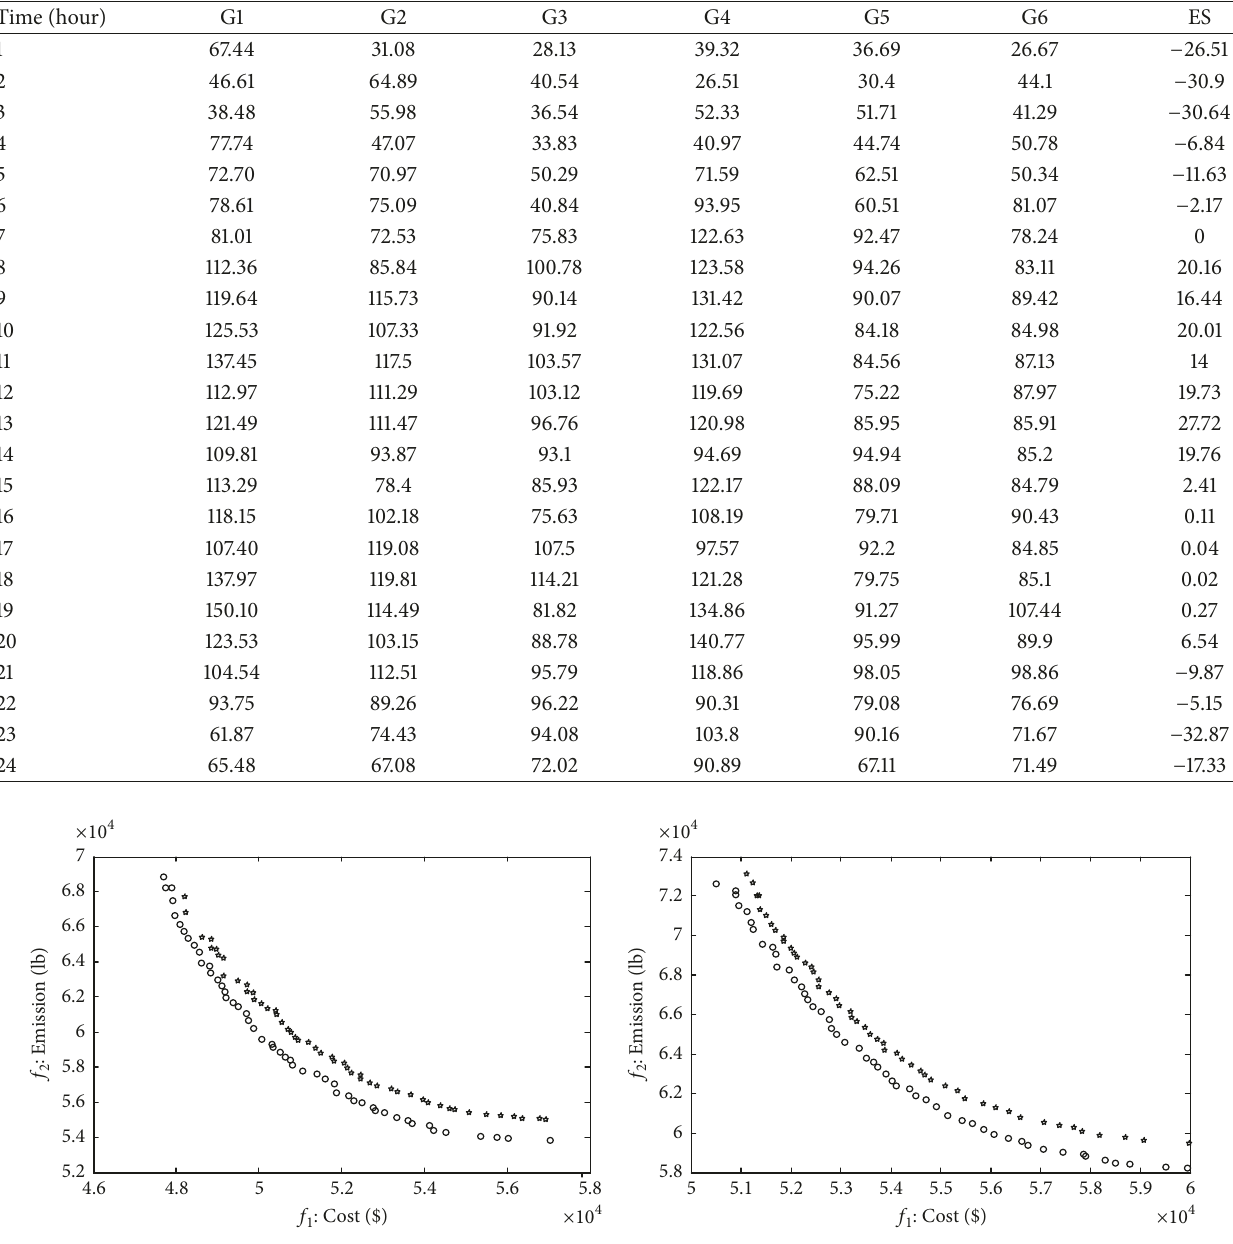
Table 4: Dispatch of compromise solution in Case 2 with 10% WP error ( 𝑓 1 = 5.40 × 10 4 $, 𝑓 2 = 5.89 × 10 4 lb).